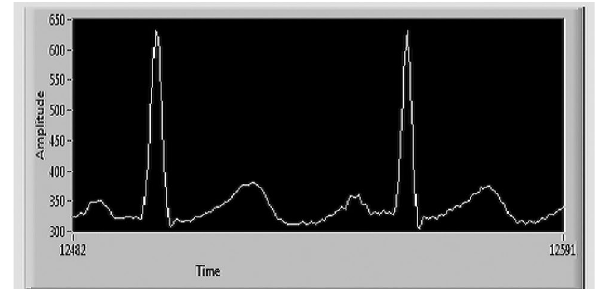
Fig. 18 The result of LabVIEW design